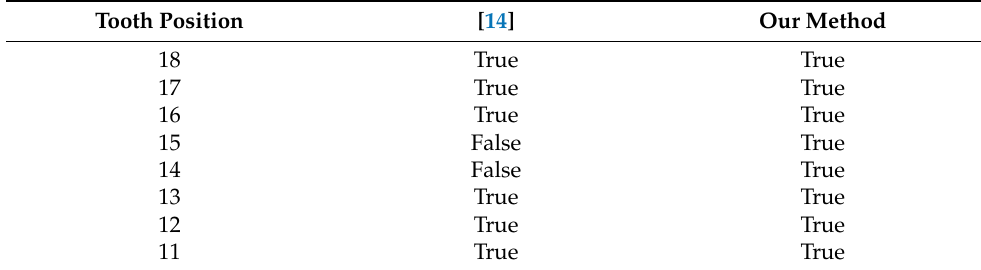
Figure 26. ( a ) Edge-marking point before correction and ( b ) after correction. Table 1. The results of edge point